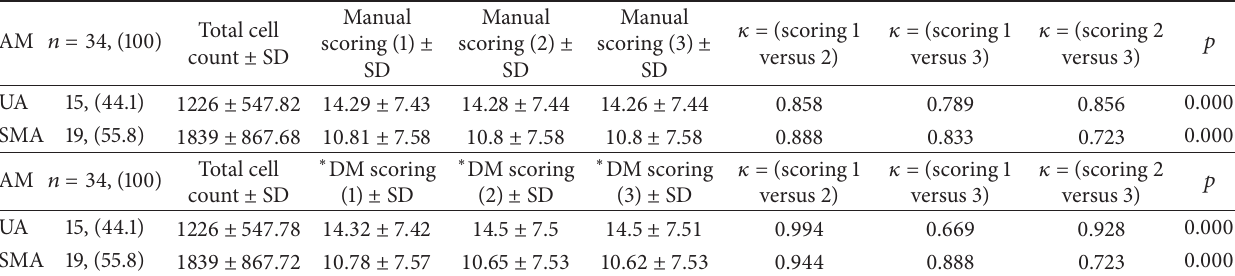
Table 1: Cell counts used to determine the labeling index were obtained with manual methods: manual scoring and DM scoring. The total tumor cell count per ameloblastoma variant and the kappa coefficient obtained for each rater are shown. 𝜅 = (scoring 1 versus 2, 1 versus 3, and 2 versus 3). The kappa coefficient ranged from substantial to almost perfect with 𝑝 = 0.000 in all cases. ∗ Digital manual scoring/ImageJ scoring.